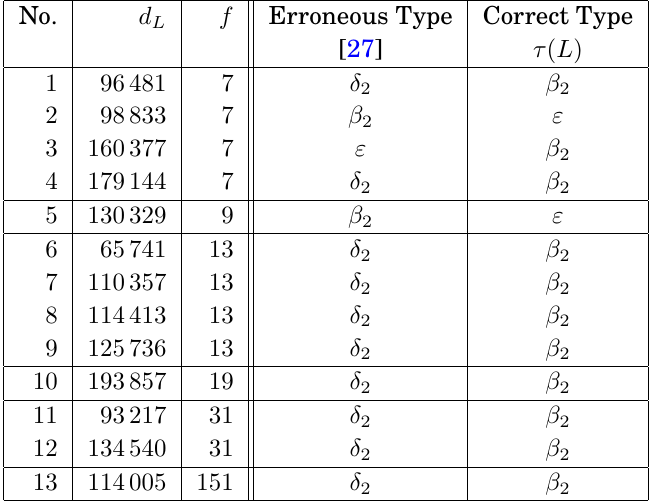
Table 9: Corrections in the range 0 < d L < 2 · 10 5